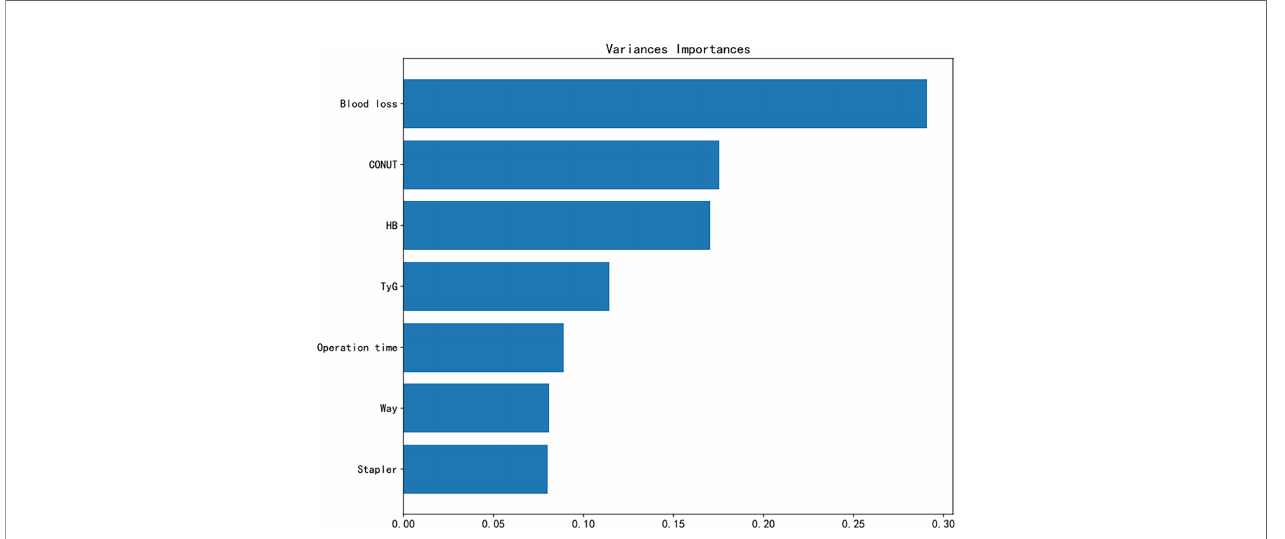
FIGURE 5 | Variable importance of the features included in extreme gradient boosting (XGB) for prediction of blood transfusion.